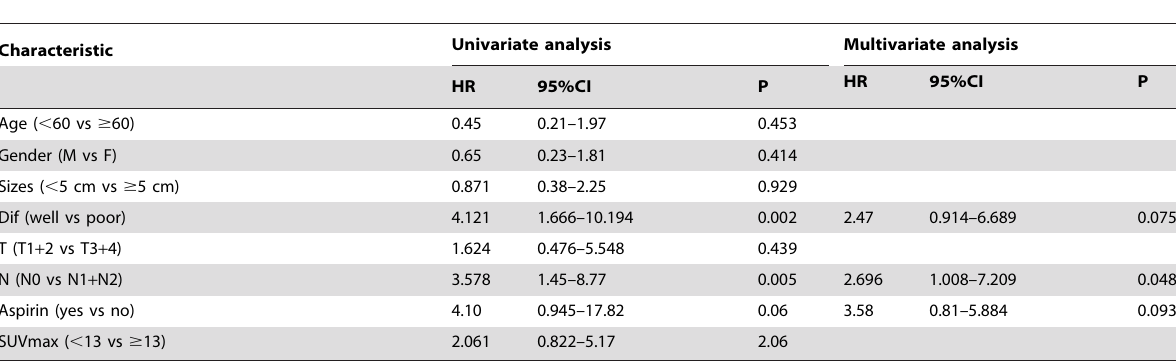
Table 3. Univariate and multivariate analysis of prognostic factors of